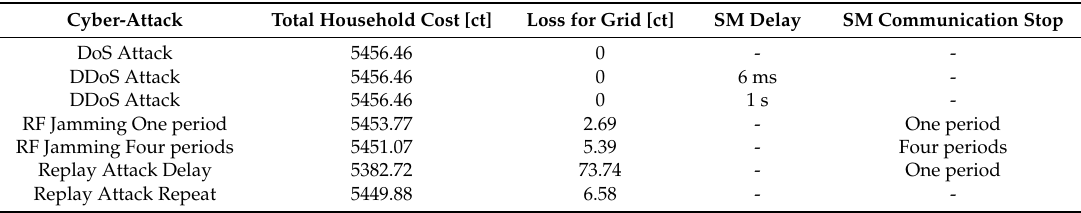
Table 6. Results of the simulation of availability attack